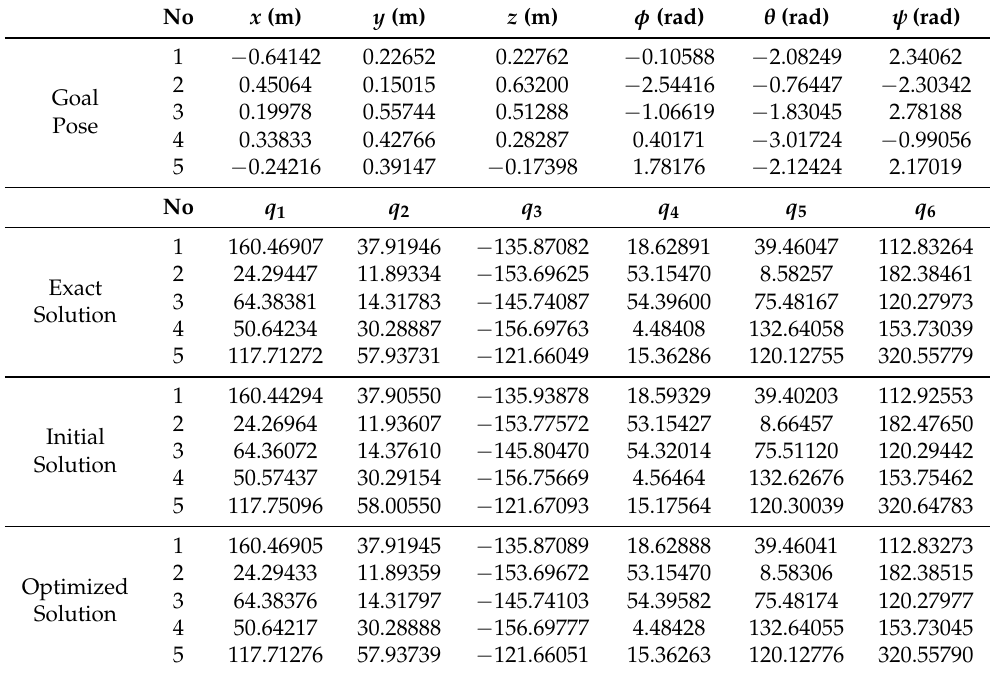
Table 6. Example of random data